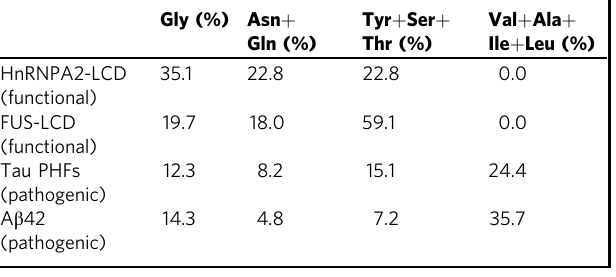
Table 5 Comparative sequence composition of functional and pathogenic amyloid fi bril